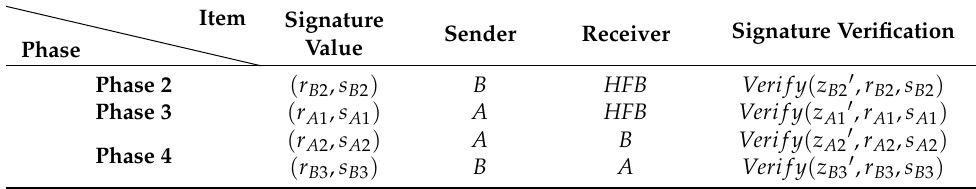
Table 3. The non-repudiation